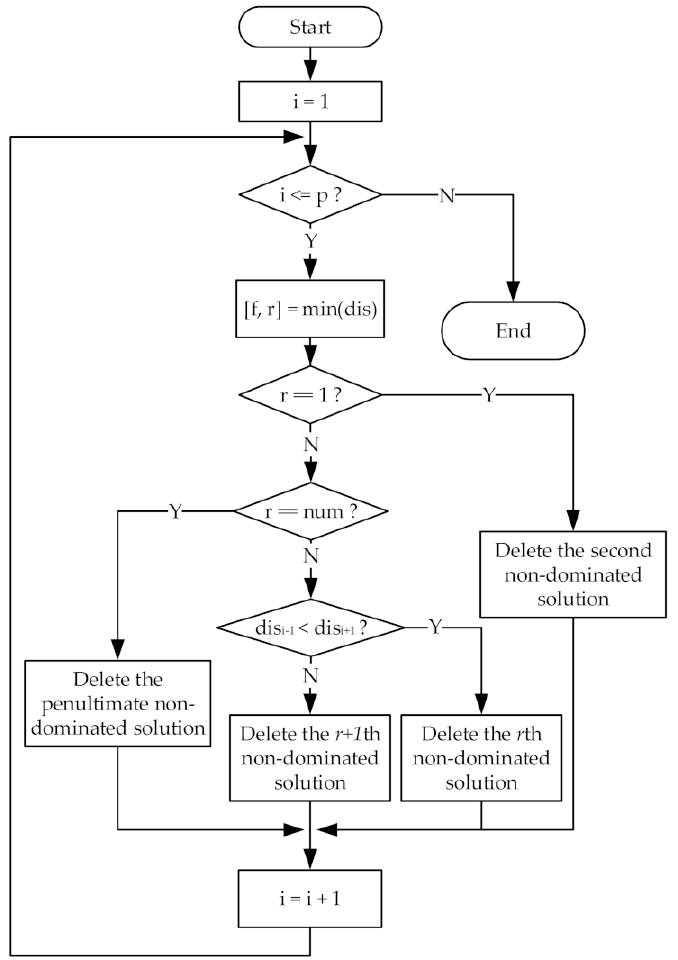
Figure 5. Flow chart of step 5 for improved Pareto distribution.